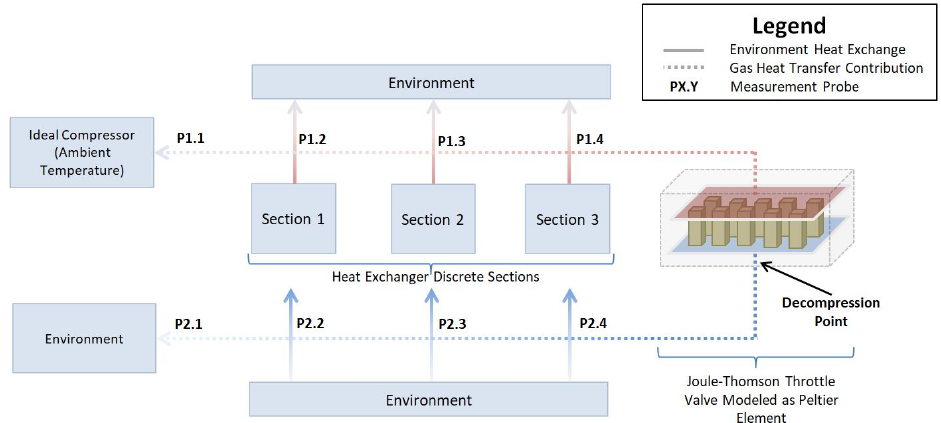
Figure 20. Thermal analysis and further functionality description of the prototype. Gradient intensity shows the temperature difference in comparison with ambient temperature. The red color shows temperatures above ambient value, while blue shows temperatures below ambient. All heat exchanger discrete sections correspond to Figure 14.